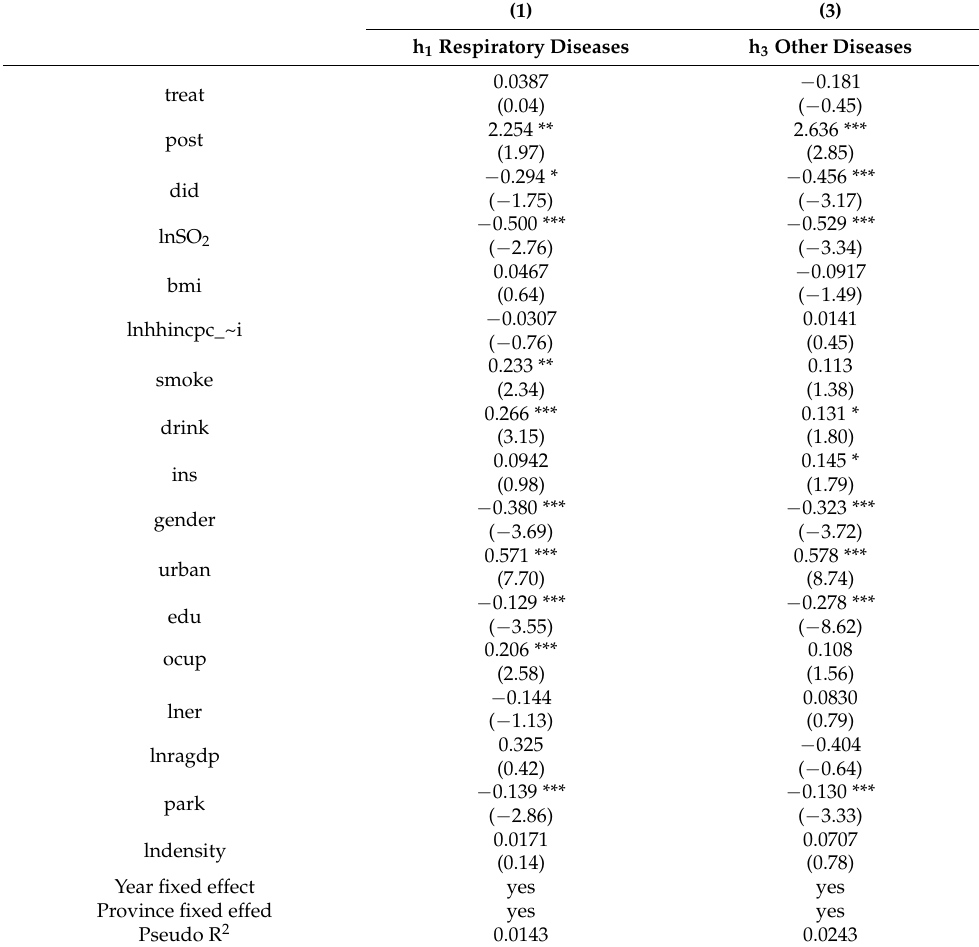
Table 4. Mechanism analysis